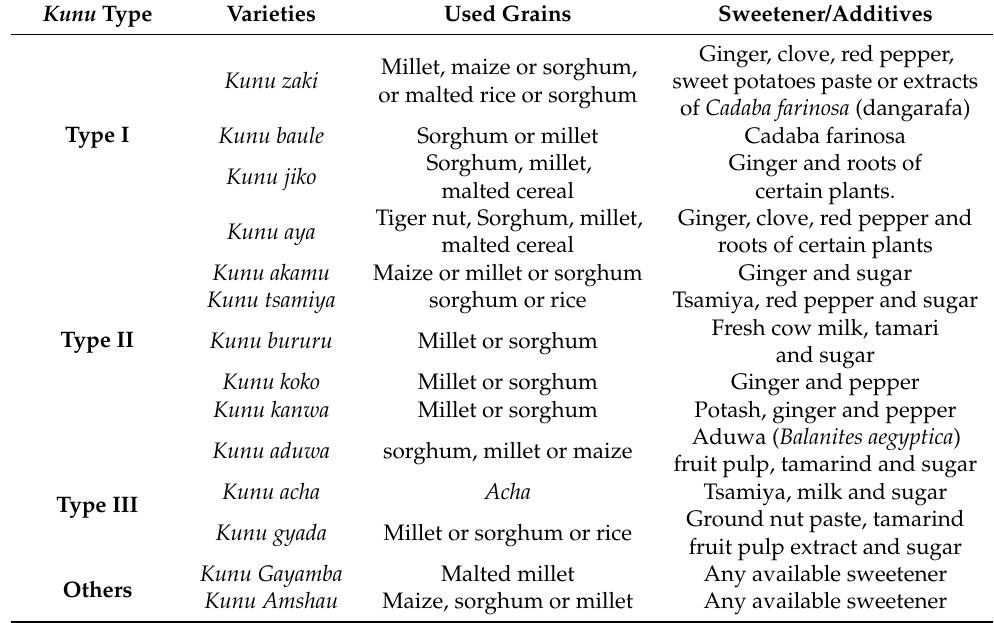
Table 1. Kunu beverage varieties and their different formulating